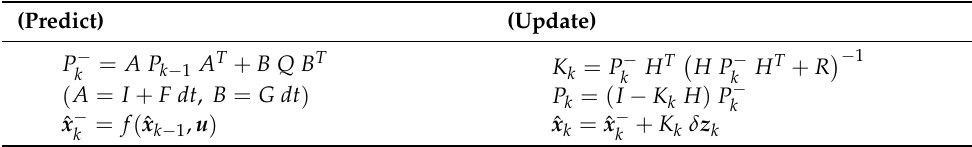
Table 1. Extended Kalman Filter’s formula.